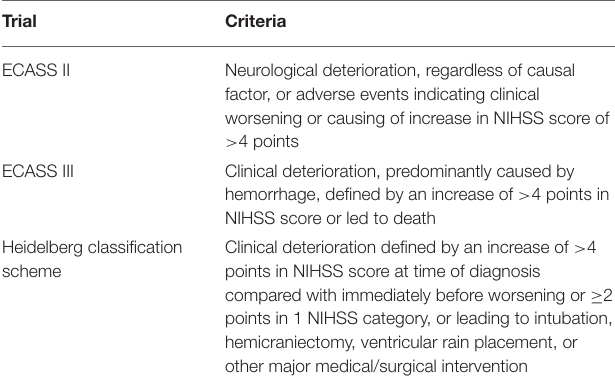
TABLE 1 | Criteria used by the included studies for symptomatic intracranial hemorrhage